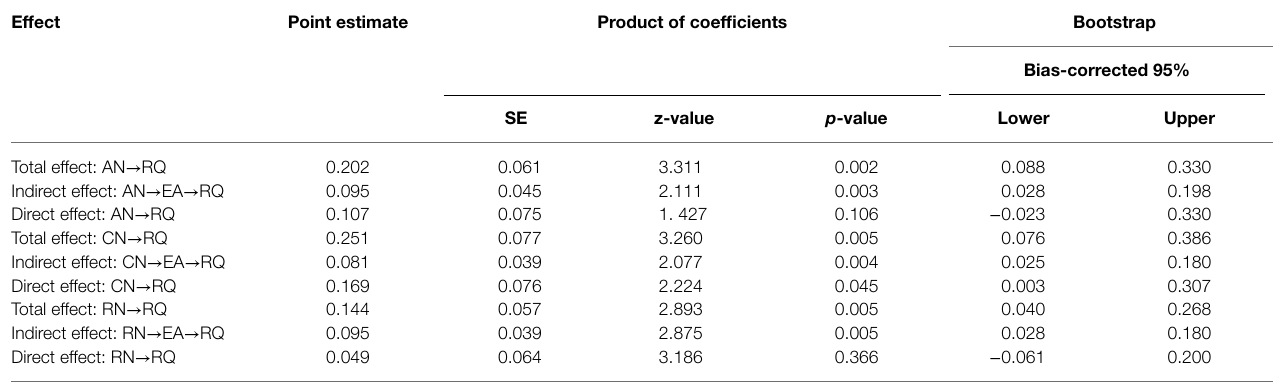
TABLE 6 | The analysis of mediation effect.